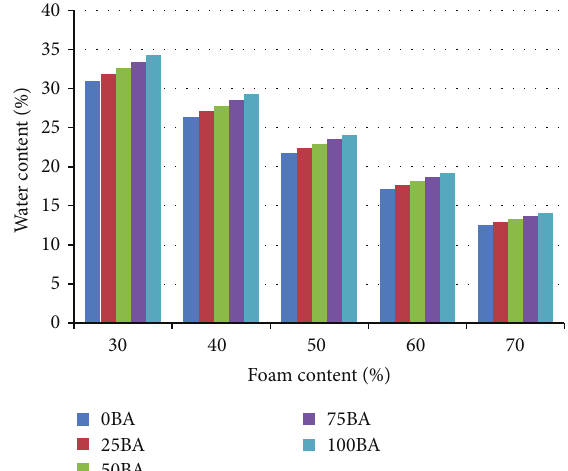
Figure 3: Water content of cellular